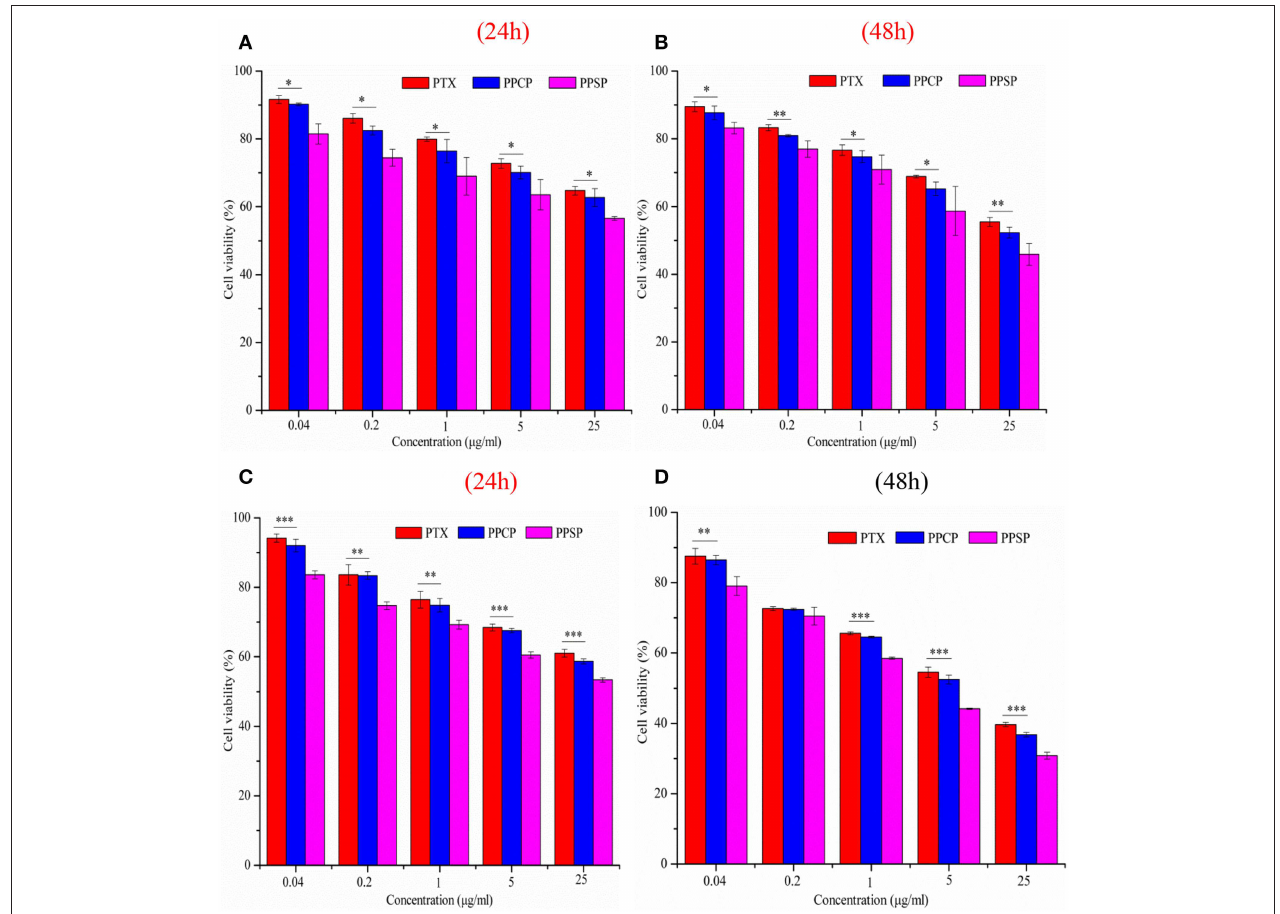
FIGURE 7 | Cytotoxicity of micelles against HepG2 cells (A,B) and MCF-7 cells (C,D) for 24 and 48h, * P < 0.05, ** P < 0.01, *** P < 0.001.